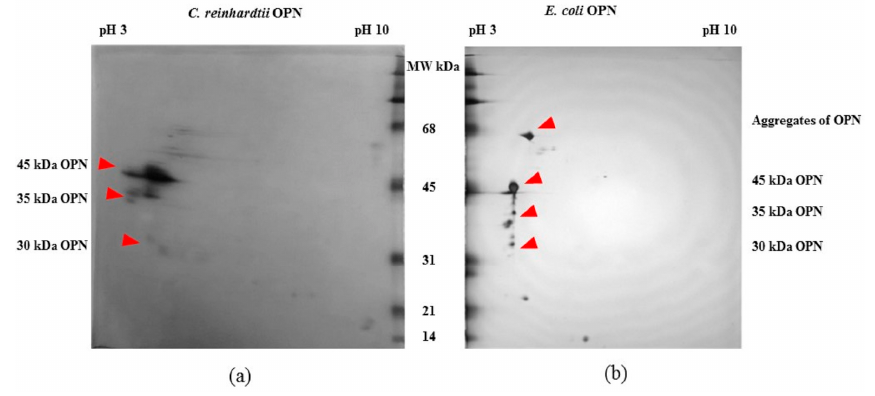
Figure 2. 2D gel electrophoresis of OPN from transgenic ( a ) C. reinhardtii and ( b ) E. coli lysates obtained by FLAG-affinity purification.